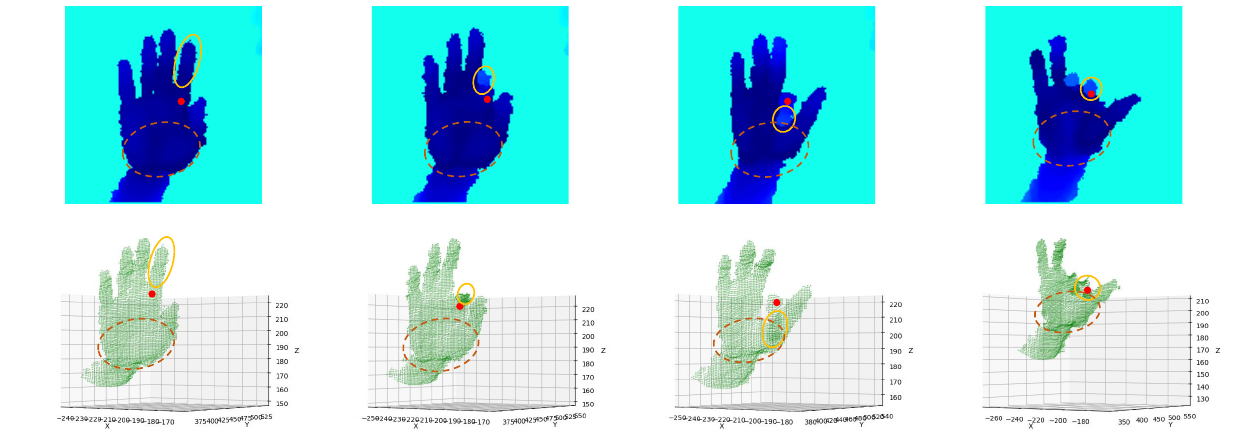
Figure 4. Qualitative results of the spatial correlations between the MCP joint of the index finger and different parts of the hand. The red point denotes the center of the MCP joint of the index finger. The solid orange boundary indicates the area of the index finger. The brown dashed boundary indicates the area of the